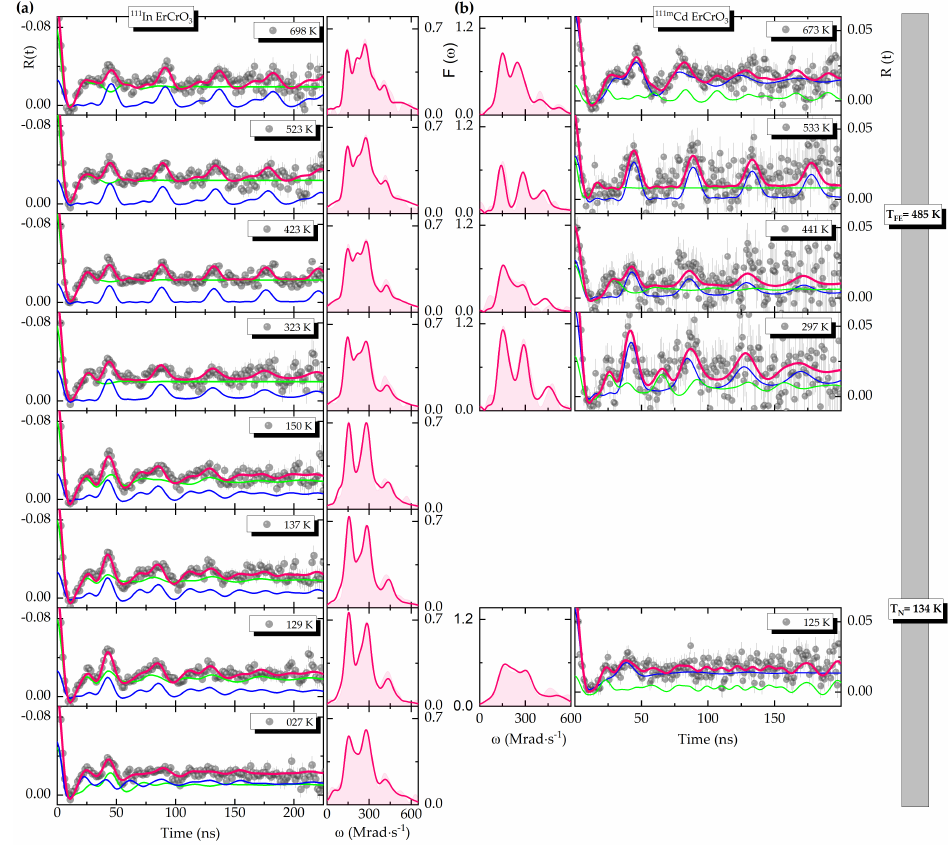
Figure 2. Representative R ( t ) functions (dots), corresponding fits (thick pink lines), and respective Fourier transform taken at different temperatures for the ( a ) 111m Cd and ( b ) 111 In probes in ErCrO 3 . Thinner blue and green lines represent the individual fractions of the total